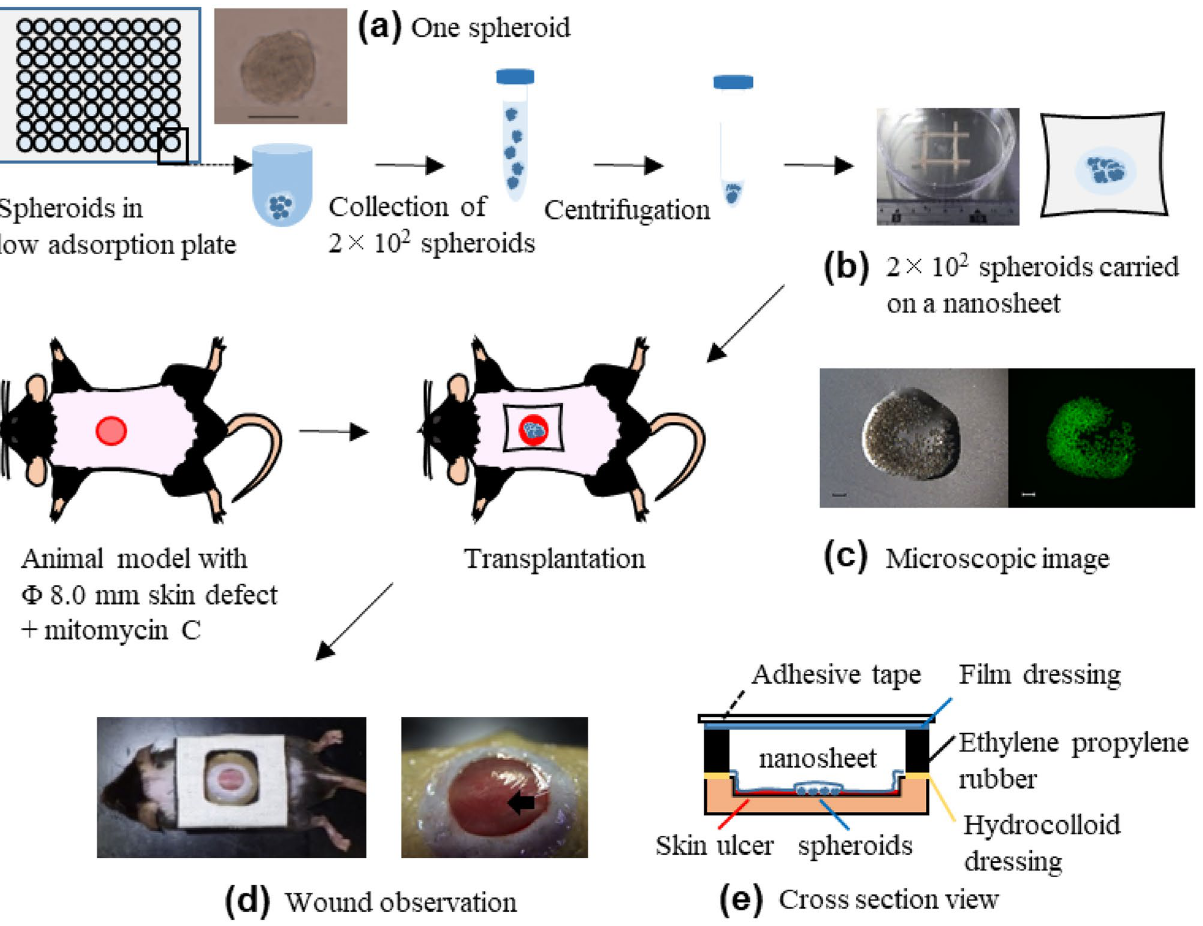
Figure 1. Outline of making animal models. ( a ) One spheroid consisting of 1 × 10 3 ASCs was formed in a well of a low adsorption plate. Two hundred ASC spheroids were then collected into a conical tube and centrifugated. Scale bar = 100 μm. ( b ) Concentrated 2 × 10 2 spheroids were resuspended in Hanks’ balanced salt solution and were gently pipetted onto the center of a pristine nanosheet with a size of 3 × 3 cm. Spheroids carried by the nanosheet were engrafted onto the refractory skin ulcer. ( c ) Left : bright-field microscopy image of spheroids carried by the nanosheet. ( c ) Right : fluorescence image. ( d ) Left : configuration of the wound dressing is shown. The wound was surrounded by hydrocolloid dressing (Yellow) and ethylene/propylene rubber (Black). The top was covered with a film dressing (Blue) and adhesive tape (White). ( d ) Right : spheroids could be observed by the naked eye through the nanosheet just after transplantation (black arrow). ( e ) Gross image of the wound after transplantation followed by several processes of